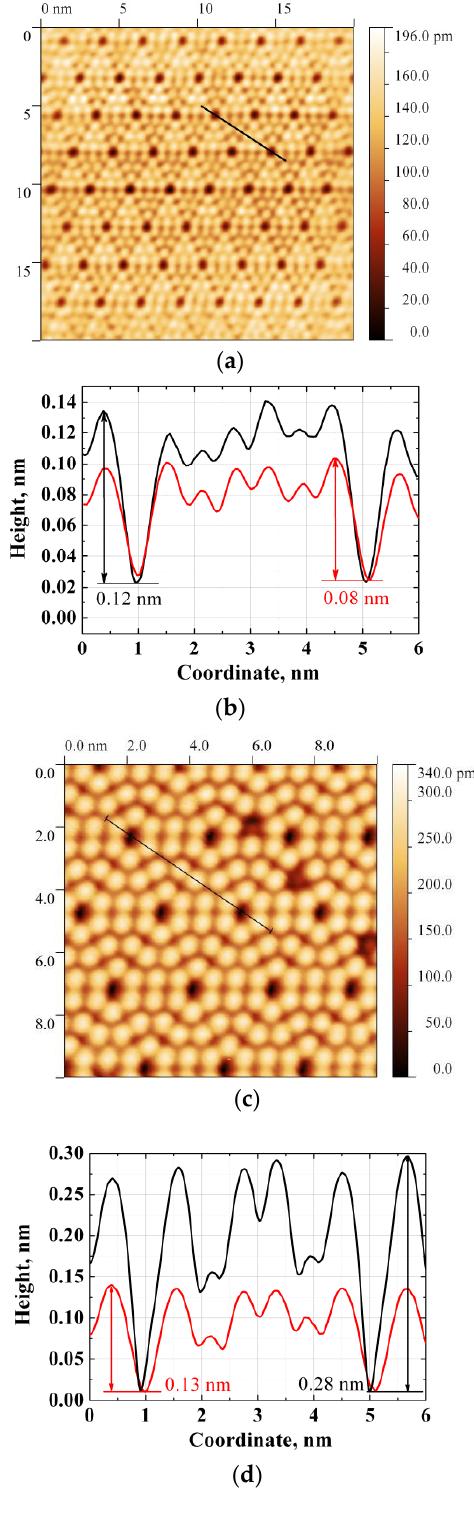
Figure 3. ( a ) Image of the (7 × 7) structure at tunnel current 0.035 nA. ( b ) Comparison of the height profiles at different operating tunneling current values: the black curve was obtained at 0.035 nA, and the red curve was obtained at 0.025 nA at the same scanning area 20 × 20 nm 2 . ( c ) Image at tunnel current 0.035 nA at scanning area 10 × 10 nm 2 . ( d ) Comparison of the height profiles at different operating tunneling current values: the black curve was obtained at 0.035 nA and the red curve was obtained at 0.025 nA at scanning area 10 × 10 nm 2 .